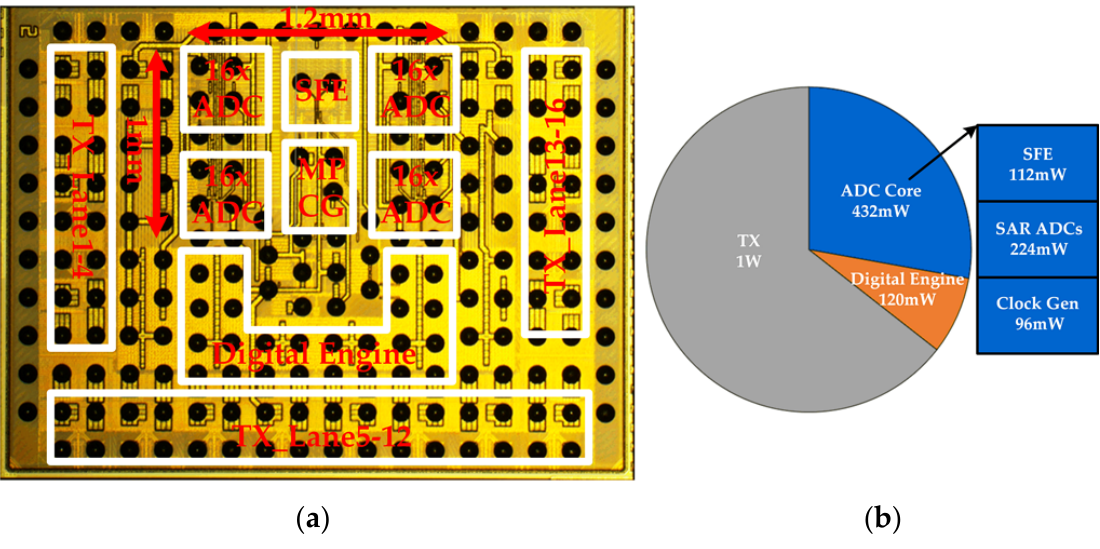
Figure 11. ( a ) Chip micrograph. ( b ) Power breakdown.